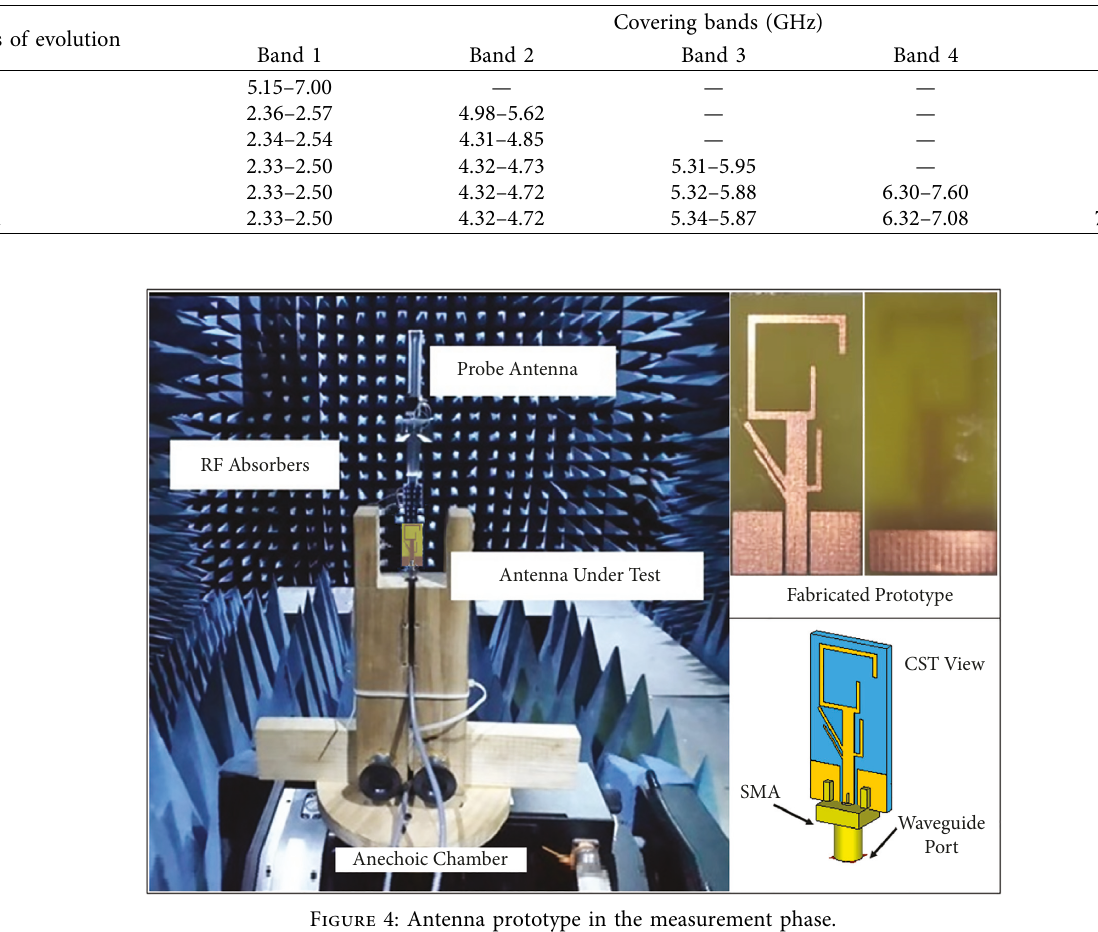
Table 2: Stepwise resonant bands during antenna design.